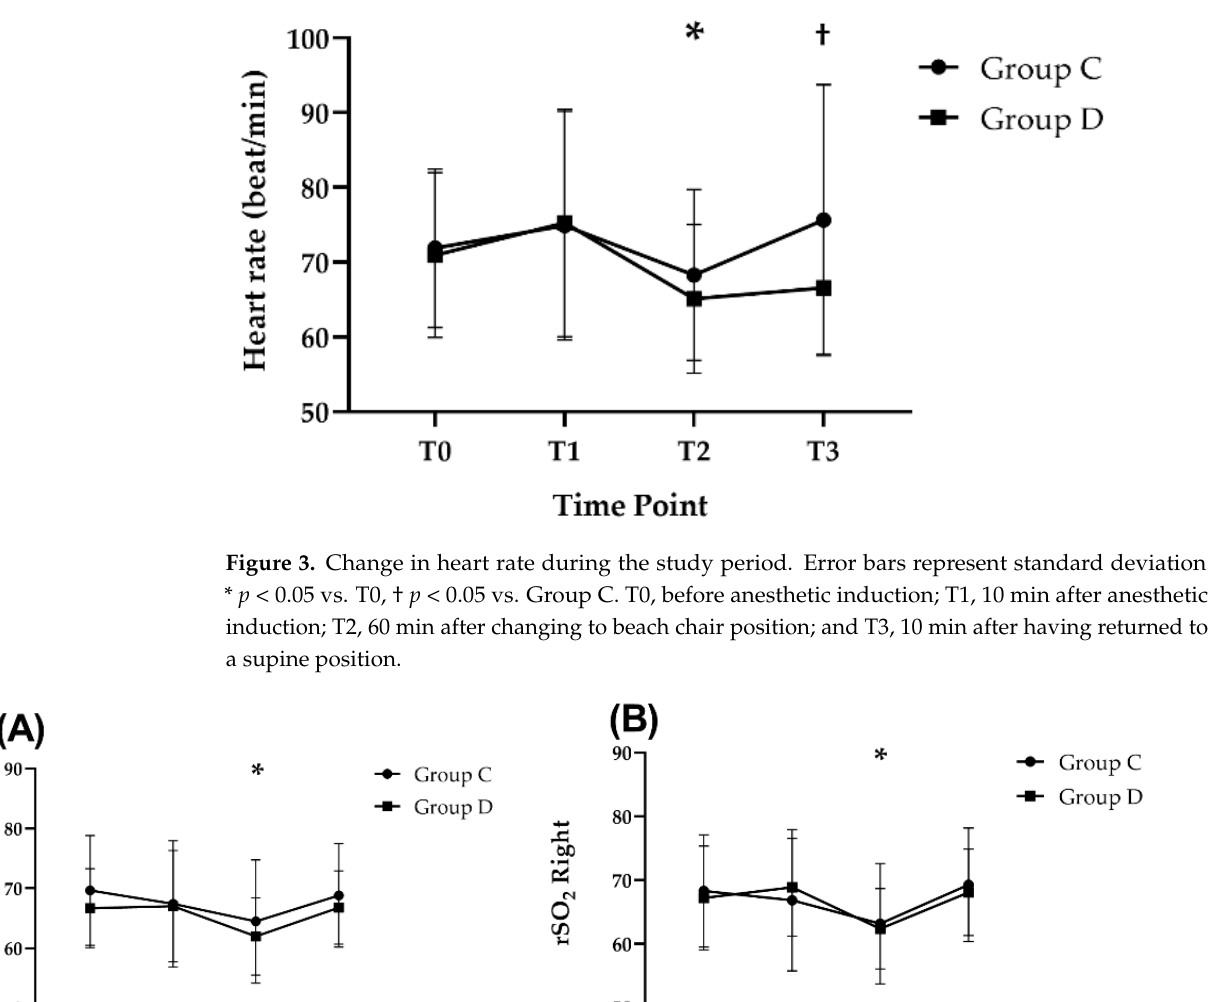
Figure 4. Change in regional oxygen saturation (rSO 2 ) during the study period. ( A ) left rSO 2 , ( B ) right rSO 2 . Error bars represent standard deviation. * p < 0.05 vs. T0. T0, prior to anesthetic induction; T1, 10 min after anesthetic induction; T2, 60 min after changing to beach chair position; and T3, 10 min after having returned to a supine position.